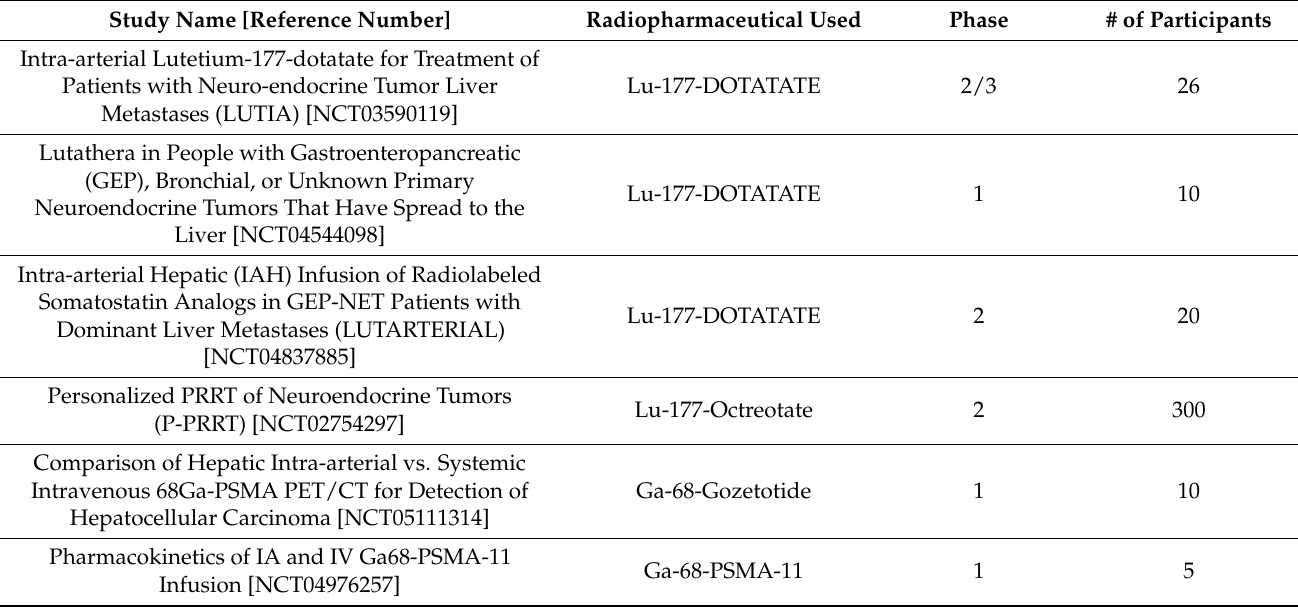
Table 3. DOTATATE- and PSMA-Related Radiopeptides Delivered via IA in Clinical